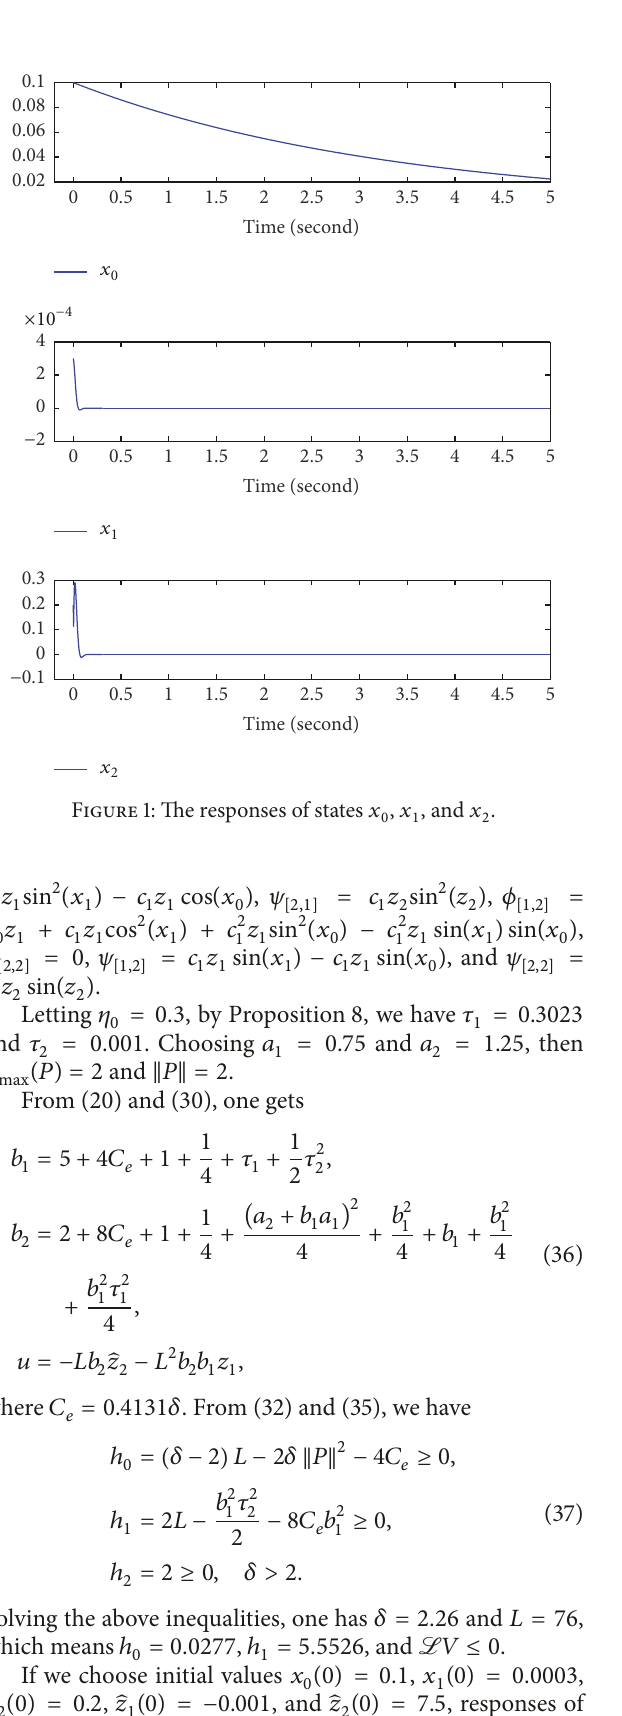
Figure 3: The responses of switching signals 𝜎(𝑡)